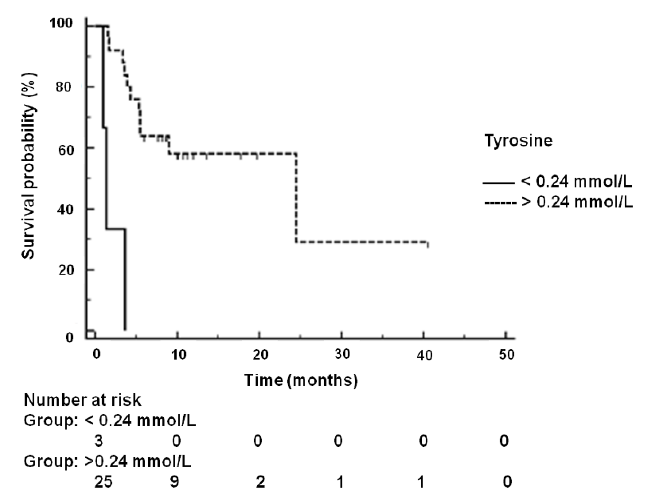
Figure 4. Kaplan – Meier analysis for overall survival (survival probability) for the whole 28 HCC patients in the early stage enrolled in this study.